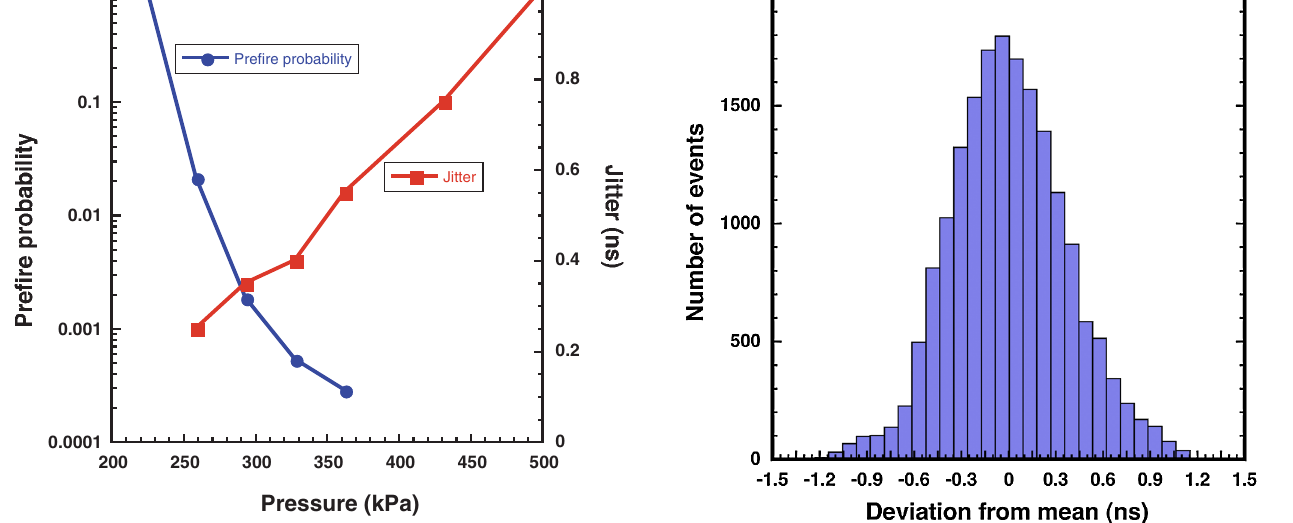
FIG. 15. (Color) Jitter of the laser itself: deviation from the mean of measured 532 nm leakage light from the trigger laser relative to a fast-rising (100 ps) trigger signal. Data are acquired on 18 000 consecutive laser-only shots, sampled at 20 ps per point. The 1 - (cid:4) standard deviation of the laser output with respect to its trigger is 375